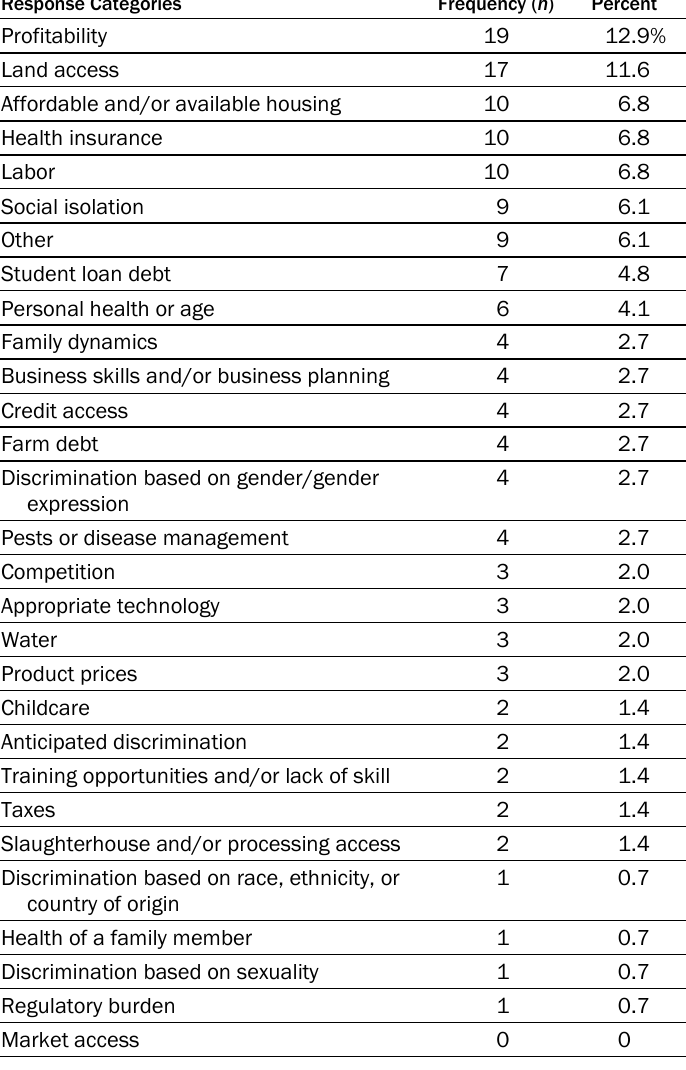
Table 3. Queer Farmers’ Most Significant